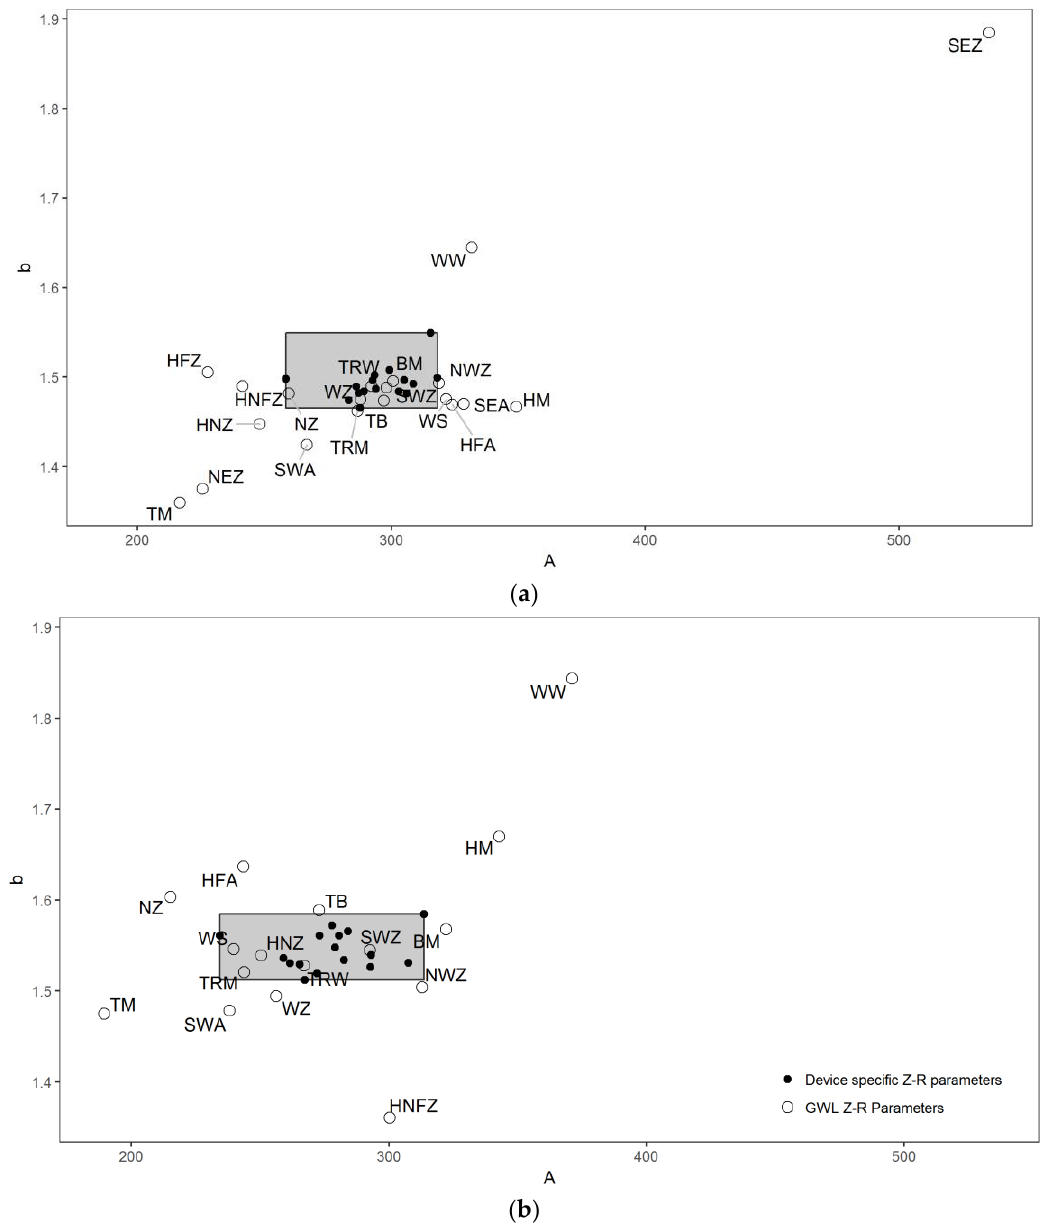
Figure 7. A and b values for the GWL Z – R model (white circles) and the 16 devices (dots) in ( a ) stratiform and ( b ) convective rain. The grey area represents the range of A and b values as they vary spatially (across the devices).